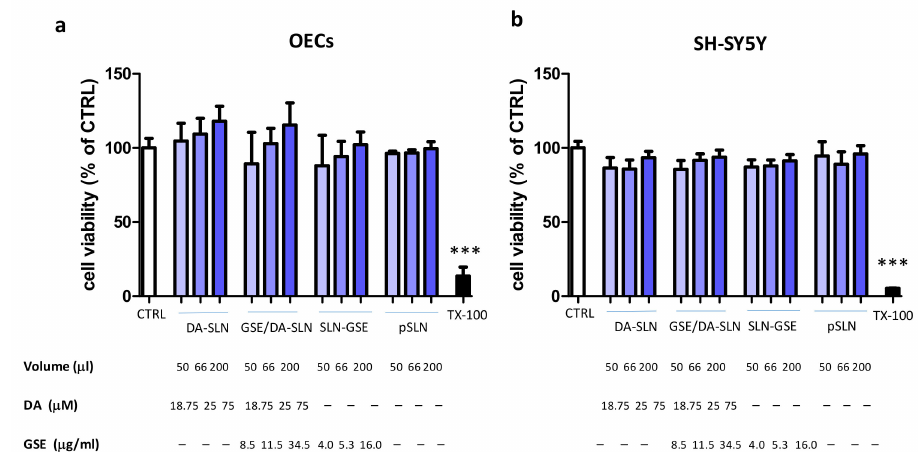
Figure 6. Cytocompatibility of SLN containing DA, GSE or DA and GSE. OECs ( a ) and SH-SY5Y cells ( b ) were challenged with DA-SLN, GSE/DA-SLN and SLN-GSE at the indicated volumes and concentrations of DA or GSE for 24 h. Plain SLN (pSLN) were used at equivalent volumes. Cells were then assayed for vitality by the MTT assay. Control (CTRL) cells are untreated cells (100% of vitality), whereas TX-100 (0.1% Triton X-100) denotes positive controls. Data are expressed as average ± SD of two experiments carried out each in six wells. *** p < 0.0001, TX-100 versus all other